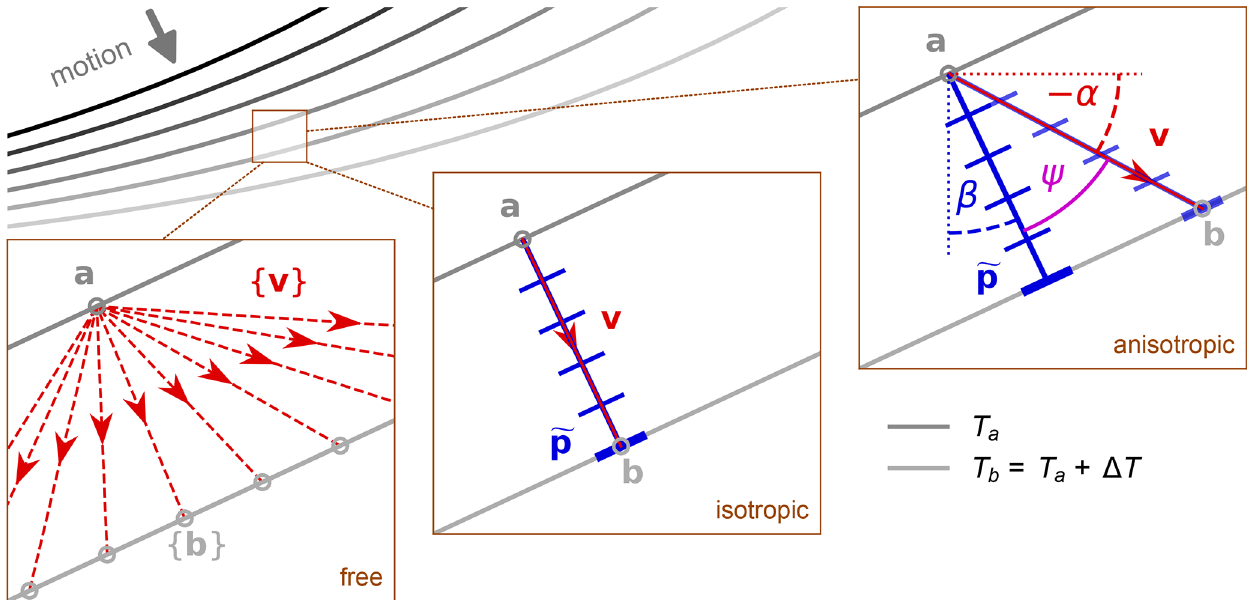
Figure 1. Illustration of how points map from one erosion surface (grey curves) at time t = T a to the next at time t = T b = T a + (cid:49)T . If the erosion mechanism is not specified (“free” inset), each point a ∈ T a (solid grey circle) can in principle be mapped to any of the points { b } ∈ T b (empty grey circles). However, if the erosion process is known, the point mapping is constrained (albeit indirectly) as follows. The erosion function can be converted into a metric function that tells us how far apart the surfaces are after the time interval (cid:49)T . We gauge this spacing using a slowness covector (cid:101) p (blue ladder symbols) oriented normal to T a and at an angle β from vertical. If we convert the metric into a Hamiltonian, we get evolution equations both for (cid:101) p and for point velocity v (red arrows; at angle α clockwise from horizontal). The point velocity determines the point pairing. If the erosion process is independent of gradient (“isotropic” inset), the metric is Euclidean, the point velocity is colinear with normal slowness, and the point a on T a maps to its nearest neighbour b on T b . If instead the erosion process is gradient-dependent (“anisotropic” inset), the metric it generates is non-Euclidean, (cid:101) p and v are not colinear, and the mapping of point a to point b is oriented at an angle ψ = α − β + 90 ◦ to the surface normal. The angle ψ is therefore a measure of erosional